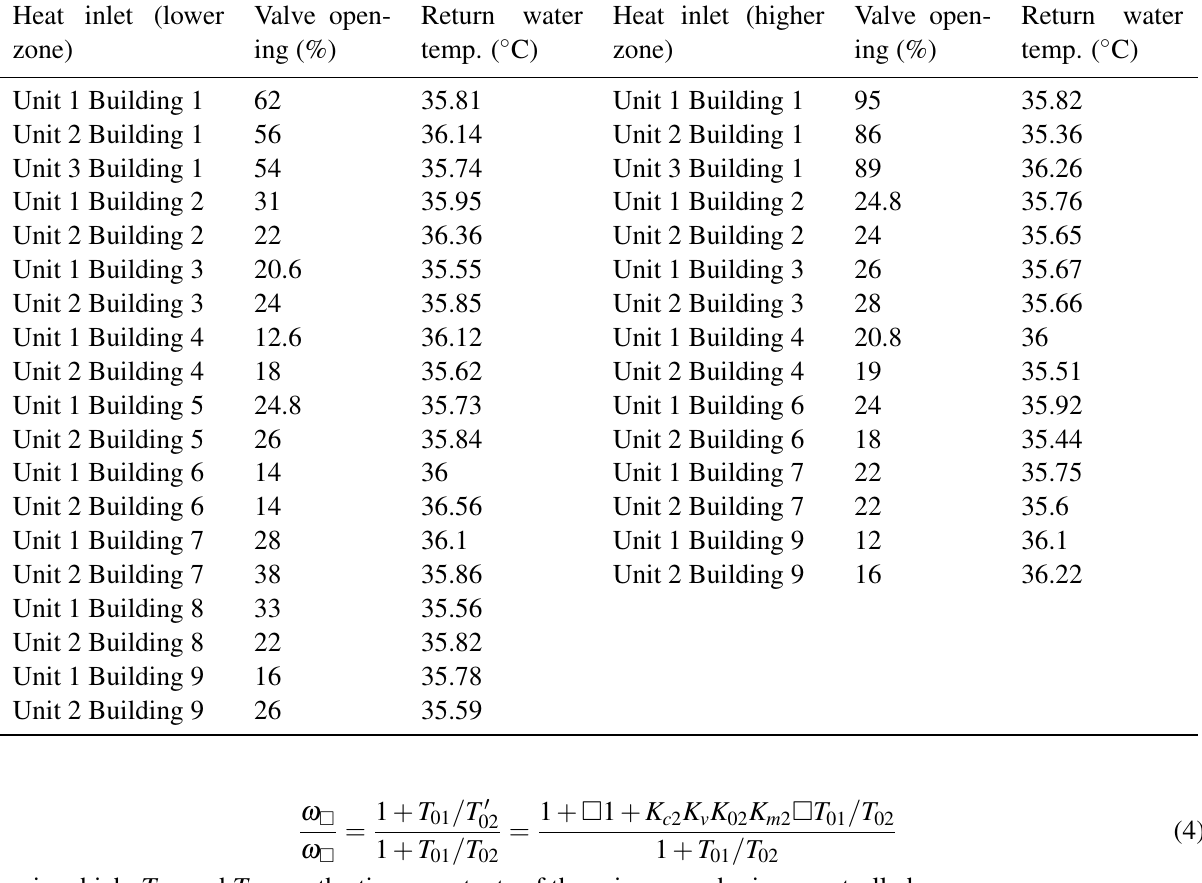
Table 4 Post-regulation valve opening and return water temperature at heat inlet of each